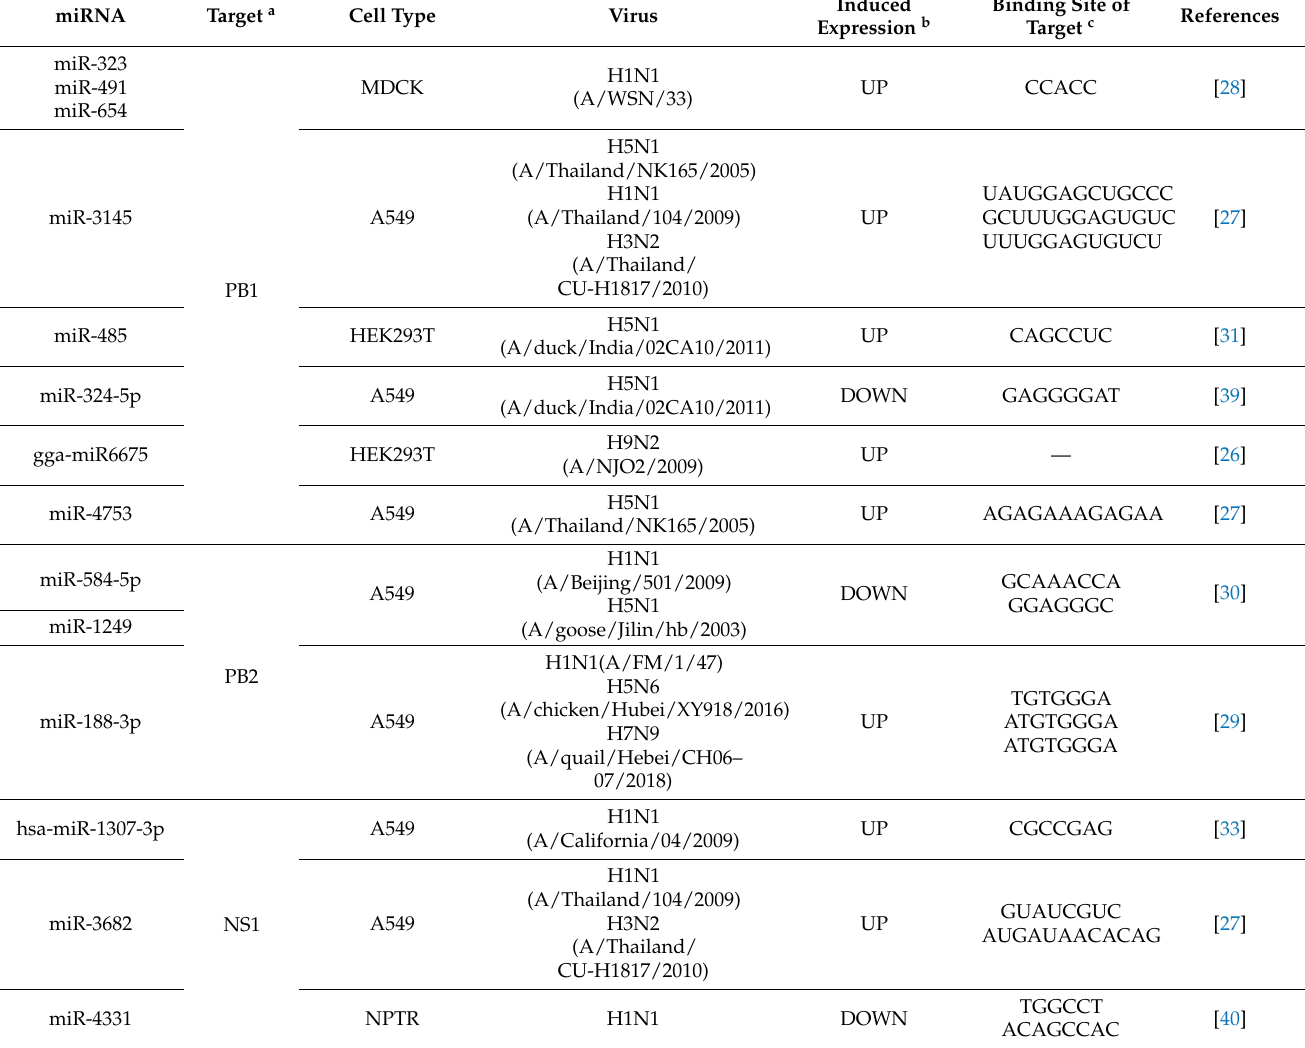
Table 1. miRNA directly targets key genes of